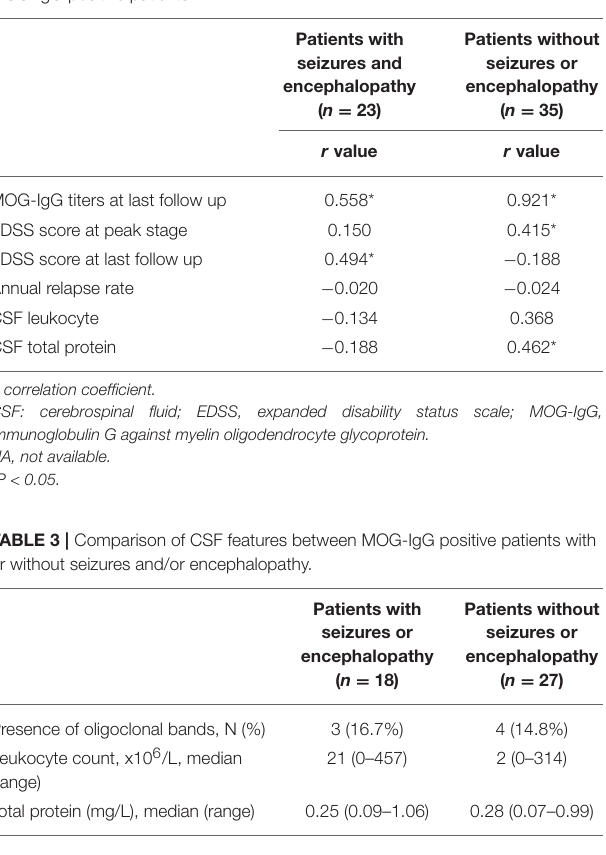
TABLE 2 | Correlations between MOG-IgG titers at relapse and clinical features in MOG-IgG positive patients.